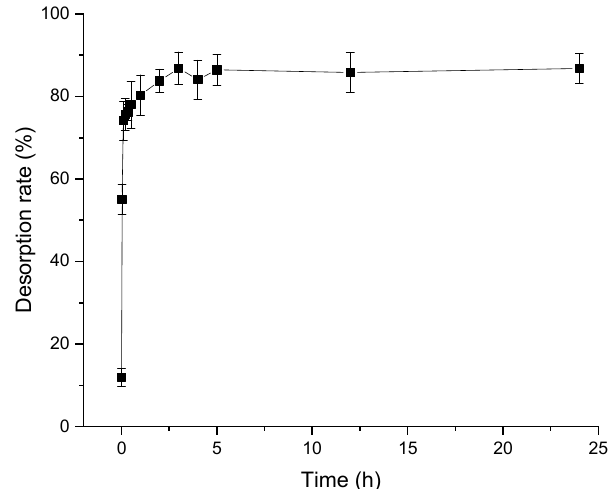
Figure 3. Static desorption kinetic curve of D101 resin (3 g) adsorbing polyphenols from distiller’s grains with 60% ethanol as eluent under the condition of 30 °C at 120 rpm for 24 h. Vertical bars represent the standard deviation of each value.